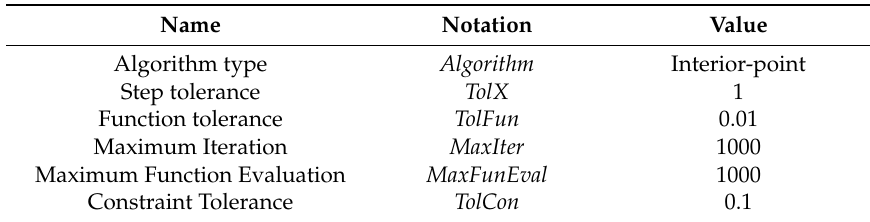
Table 2. Selected parameters of fmincon